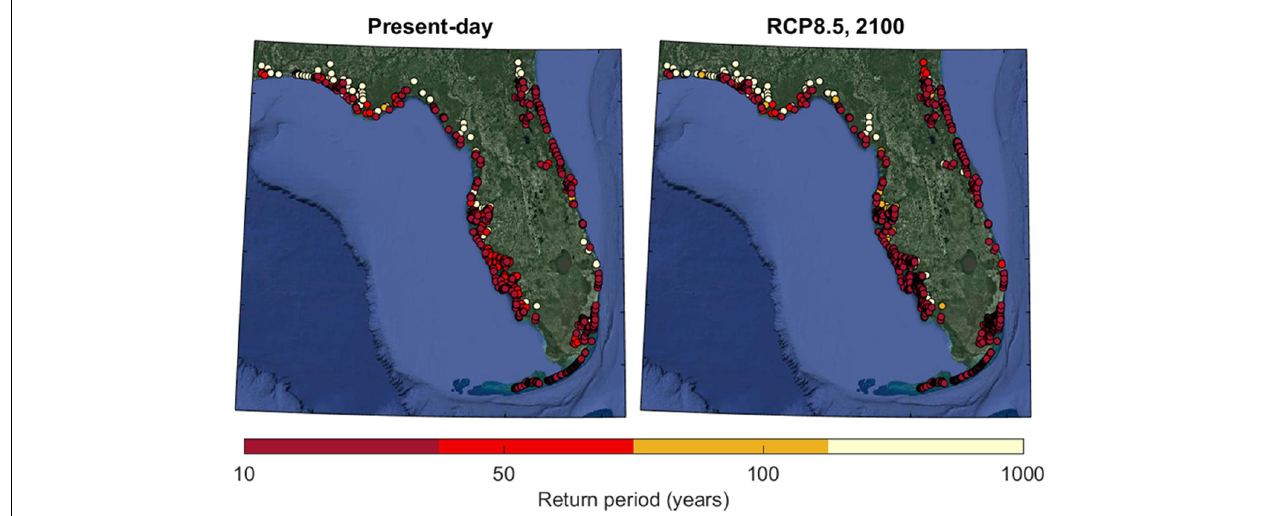
FIGURE 7 | Landfills across Florida located in the floodplain associated with different return periods (see color bar) under present sea level conditions (left) and with future SLR, considering the RCP8.5 scenario